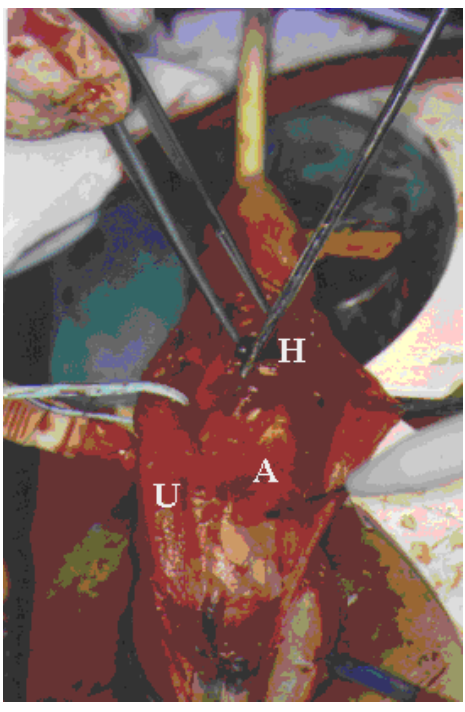
FIGURE 4. Penile shaft is degloved and Buckís fascia is entered to expose the hole (H) in the albuginea (A). The urethra (U) is isolated and pulled apart by means of a coloured rubber band.